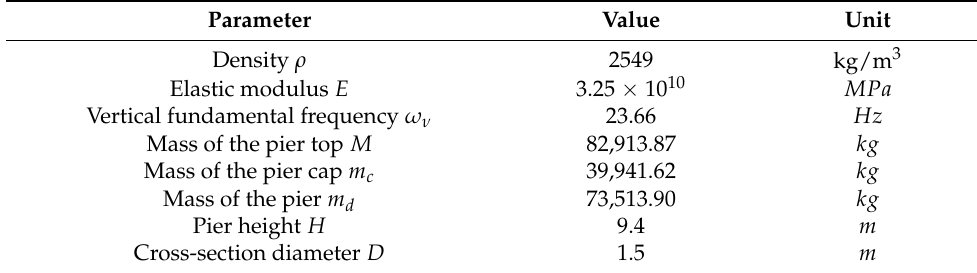
Table 2. The test pier material’s design